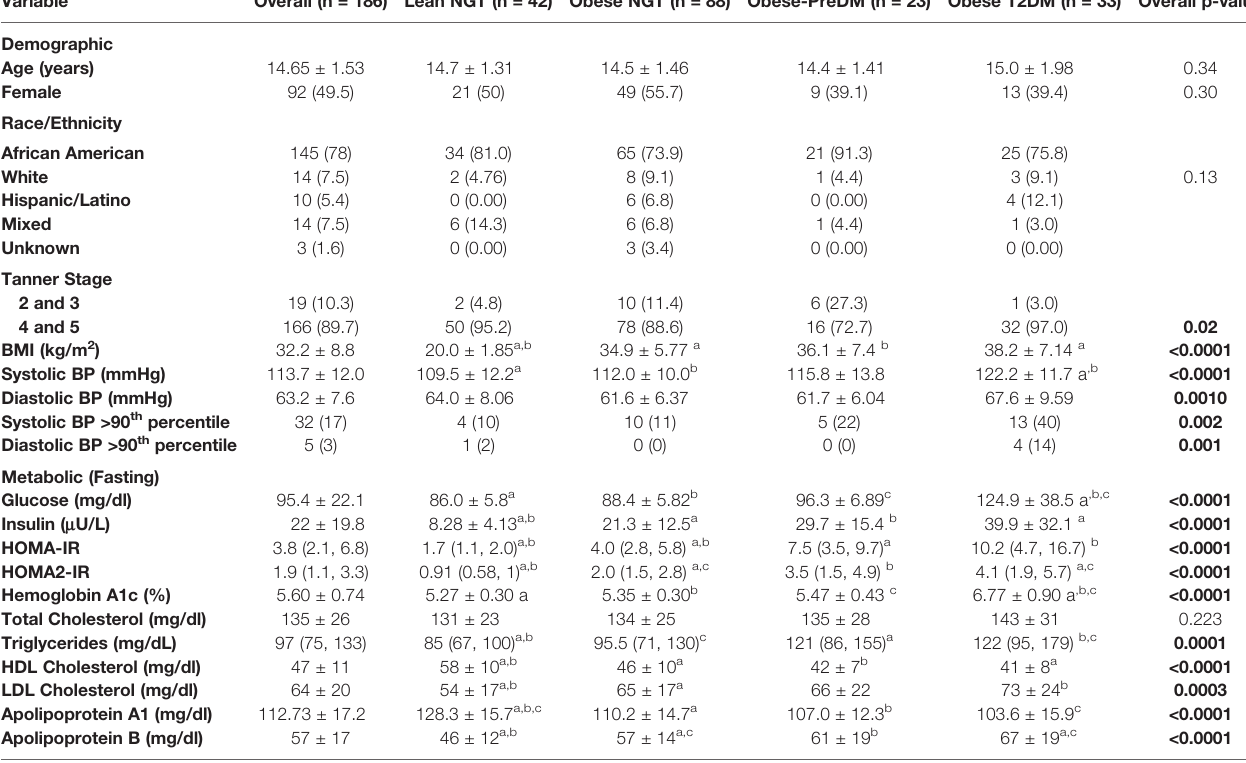
TABLE 1 | Participant Demographic and Metabolic Characteristics.